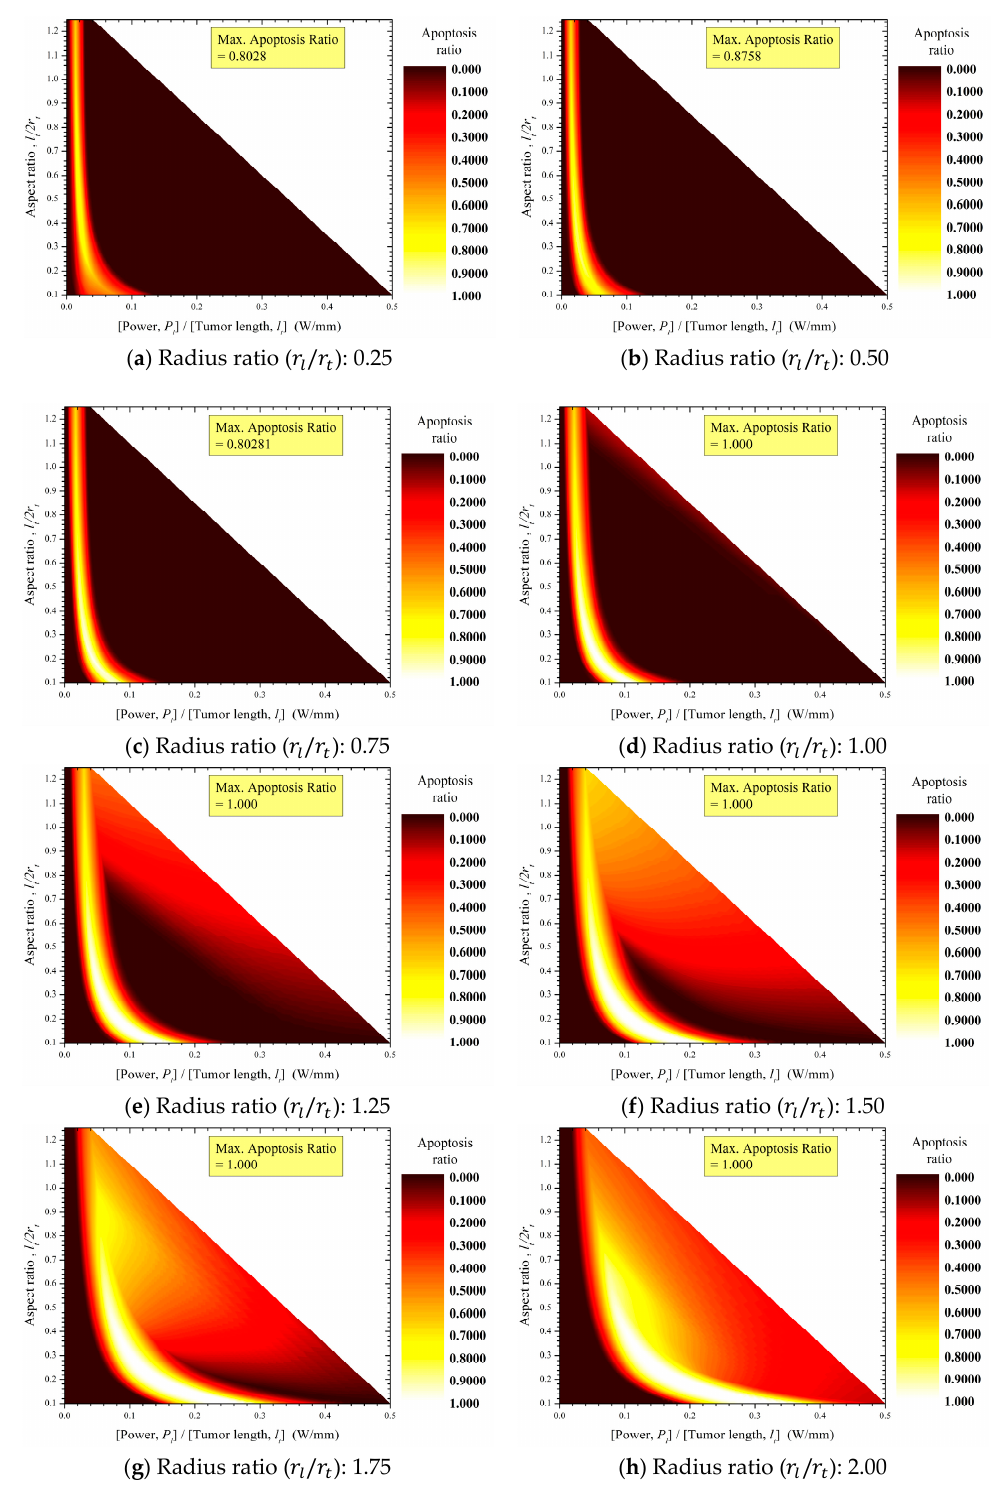
Figure 8. Contour graphs of the apoptosis ratios ( 𝜃 (cid:3002) ) in tumor tissues.